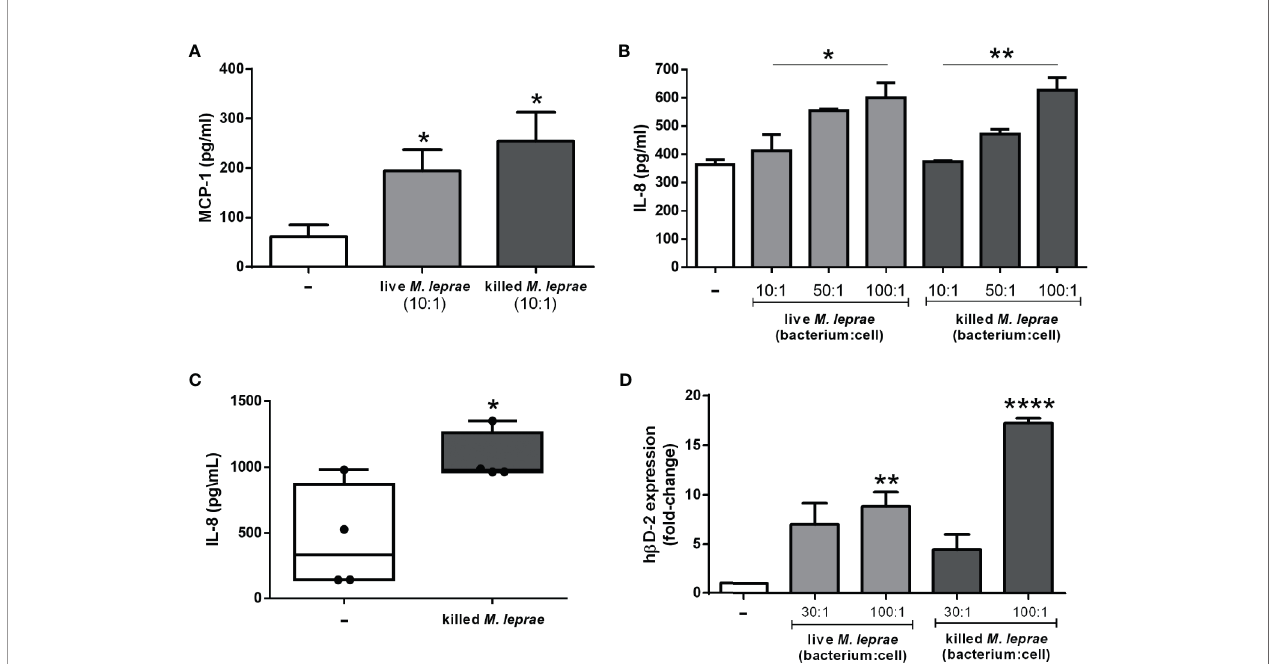
FIGURE 1 | M. leprae induces secretion of chemokines and expression of h b D-2 gene in human respiratory epithelial cells. (A, B) ELISA quanti fi cation of MCP-1 (A) and IL-8 (B) levels in the culture supernatant of A549 cells stimulated with live or killed M. leprae at different bacterium:cell ratios for 24 hours. (C) ELISA quanti fi cation of IL-8 levels in the culture supernatants of primary human nasal epithelial cells obtained from 4 donors and stimulated with killed M. leprae at a bacterium:cell ratio of 10 for 24 hours. (D) Quantitative RT-PCR analysis of h b D-2 mRNA levels in A549 cells stimulated with live or killed M. leprae at different bacterium:cell ratios for 24 hours. (A, C, D) Unpaired t -test with differences considered statistically signi fi cant in relation to the untreated cells. (B) ANOVA test with differences considered statistically signi fi cant in relation to the untreated cells comparing the different doses by applying a linear-trend post-test. *p < 0.05; **p < 0.01; ****p < 0.0001. Values represent the mean ± standard deviation of at least 3 independent experiments performed in